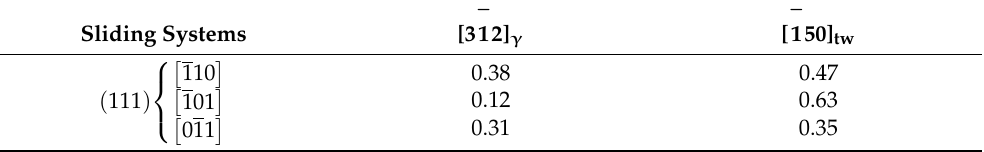
Table 2. Schmid factors for existing sliding systems for the sample area in Figure 10c. Sliding